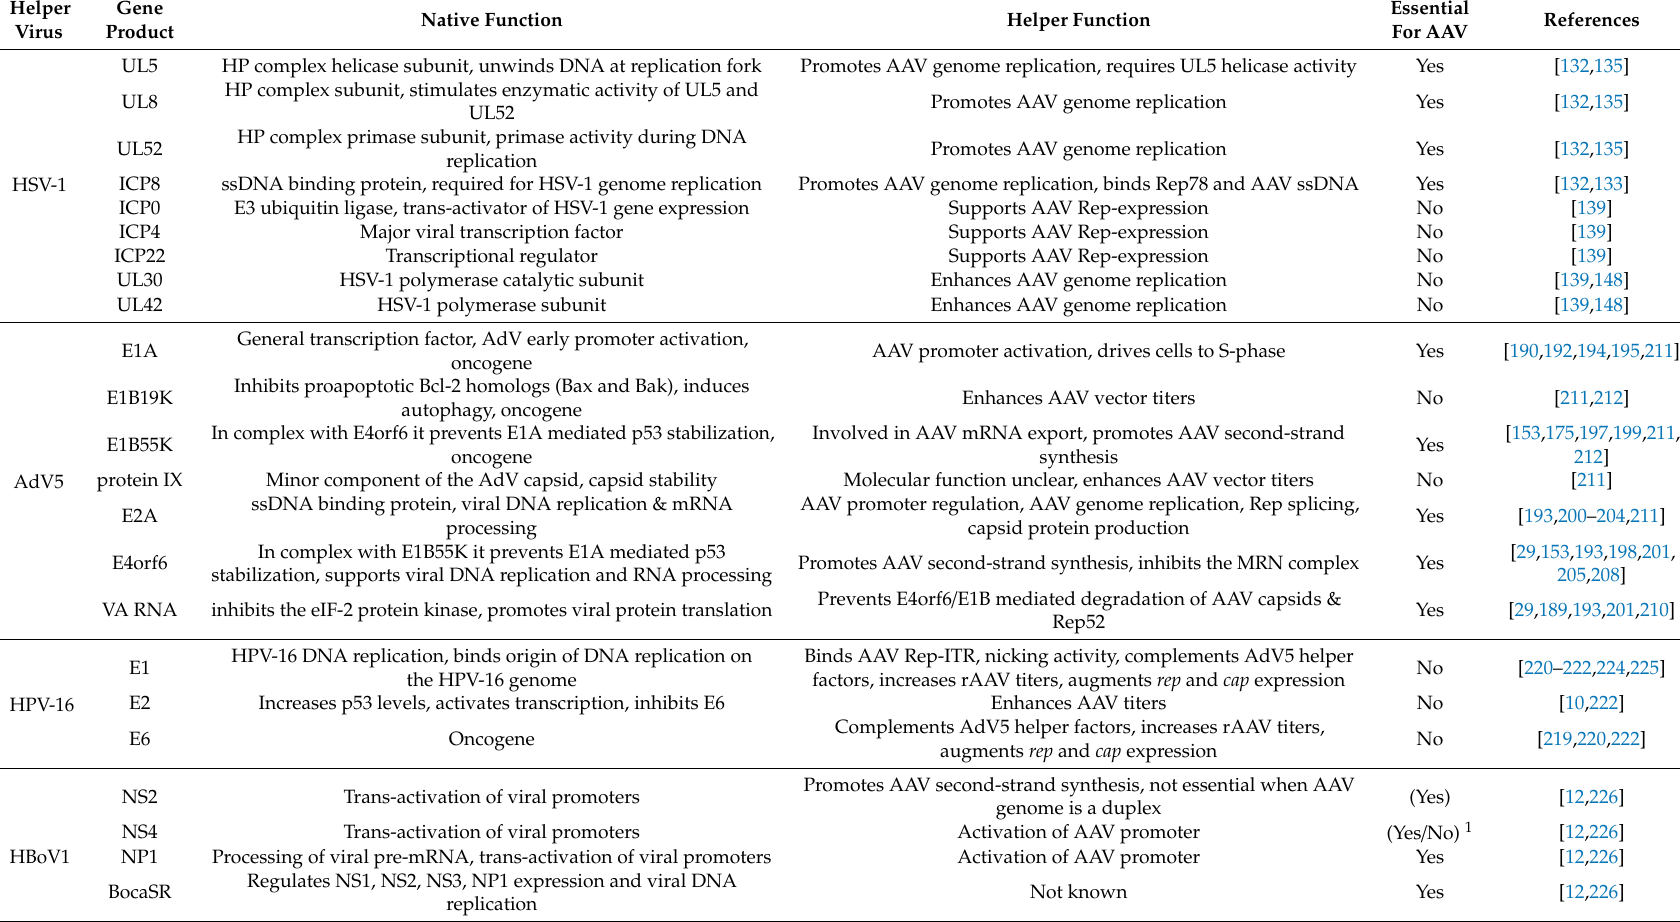
Table 1. Helper virus factors involved in supporting adeno-associated virus (AAV)